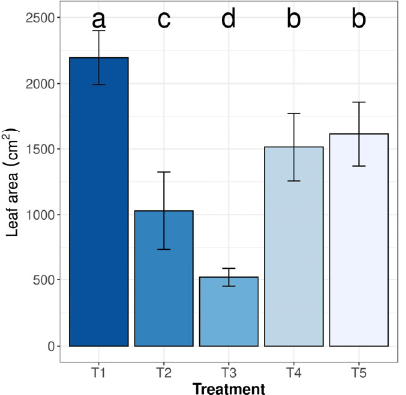
Figure 5. Leaf area of hazelnut Tonda Gentile on day of year 196 depending on substrate. T1 =